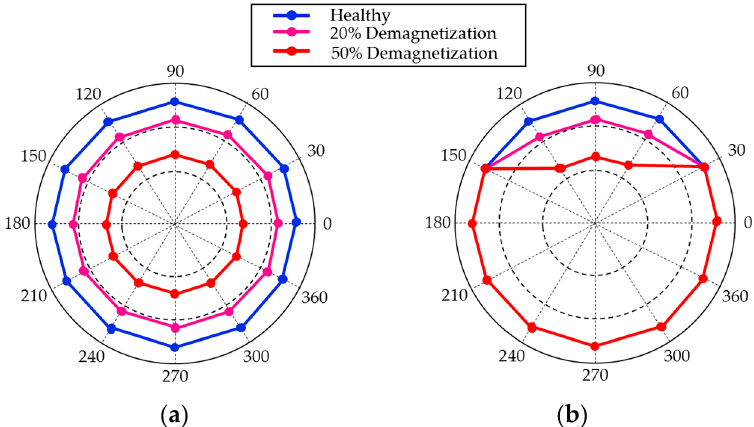
Figure 9. Magnetic field component. ( a ) Uniform demagnetization; ( b ) Partial demagnetization.